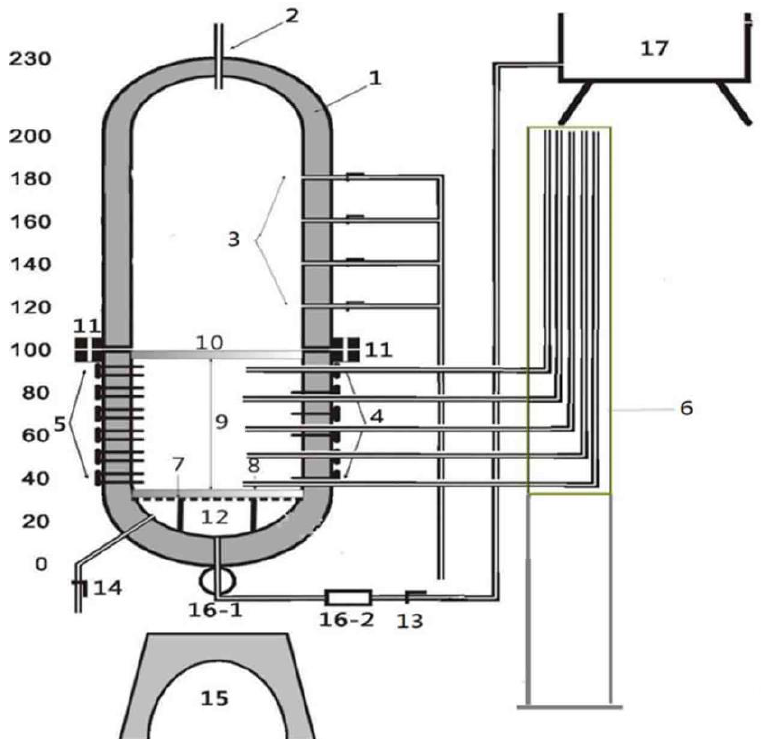
Figure 3. The schematic map of the experimental equipment. 1. Soil column; 2. top exhaust